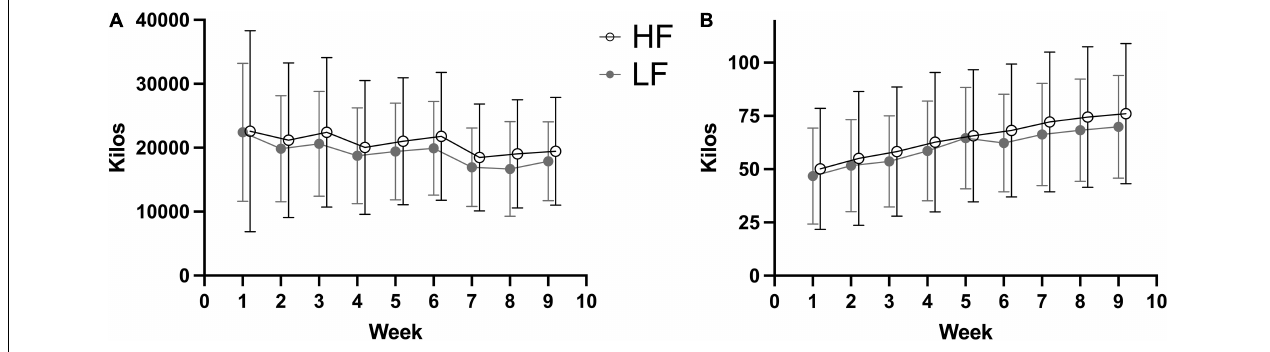
FIGURE 1 | Weekly training volume (A) and average load (B) with 2 (LF) and 4 (HF) weekly sessions during a 9-week resistance training